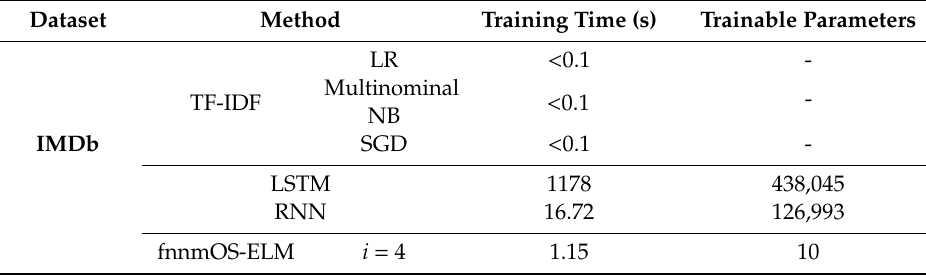
Table 3. Training time and parameters on the IMDb